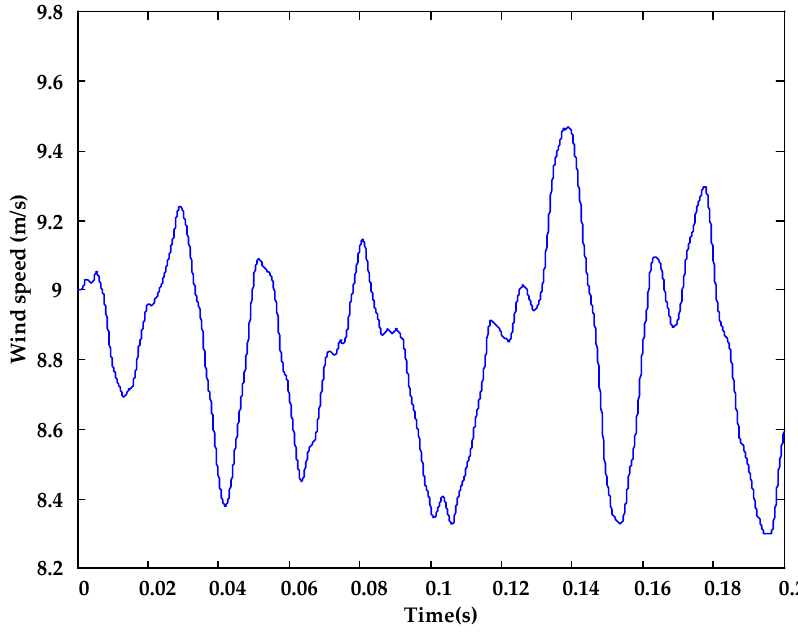
Figure 7. Weibull distribution-based wind model